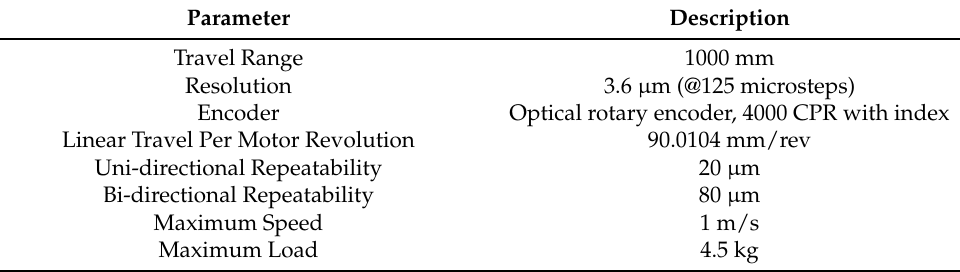
Table 3. Newmark CS-1000-1 belt drive’s linear stage